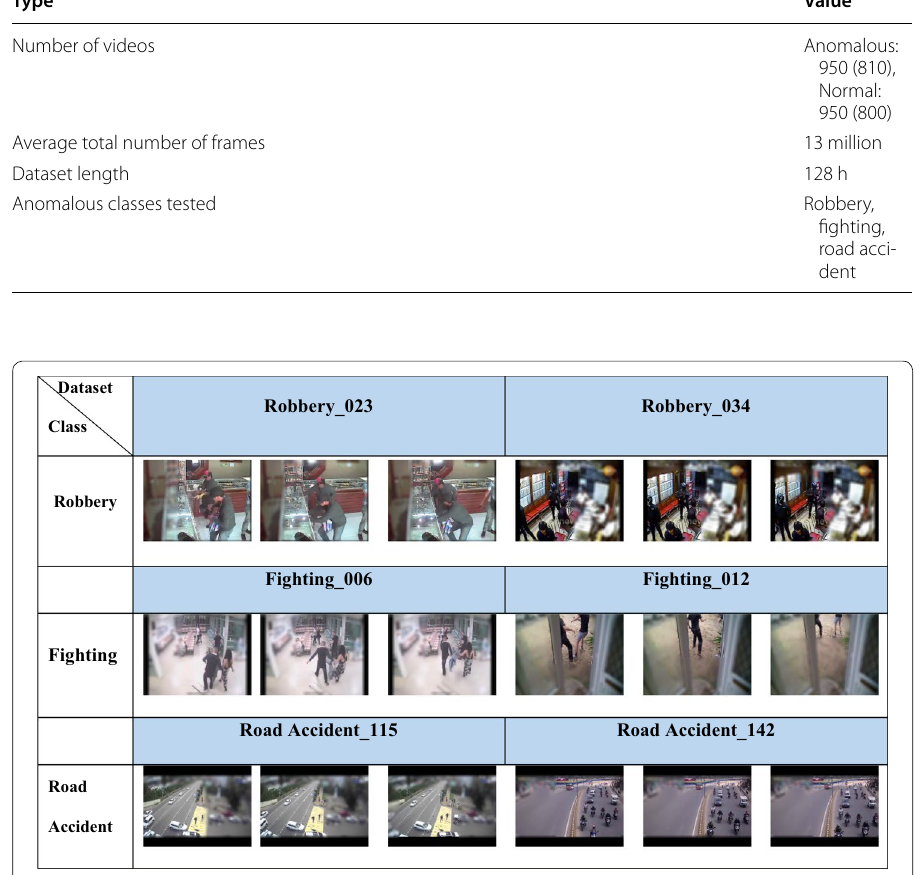
Fig. 8 Example of different anomalies in trained videos (ROI